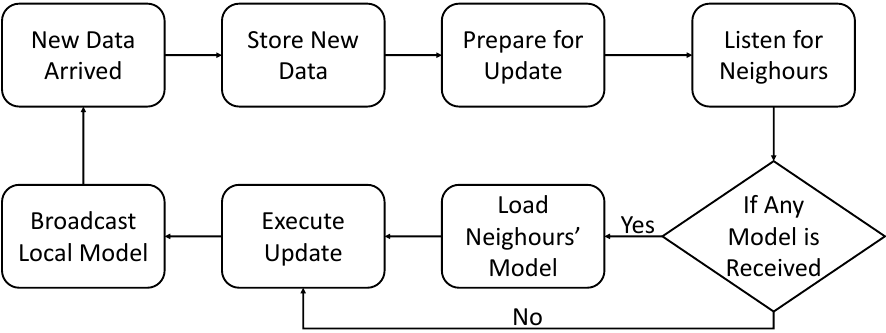
Figure 2. The workflow of the DOML